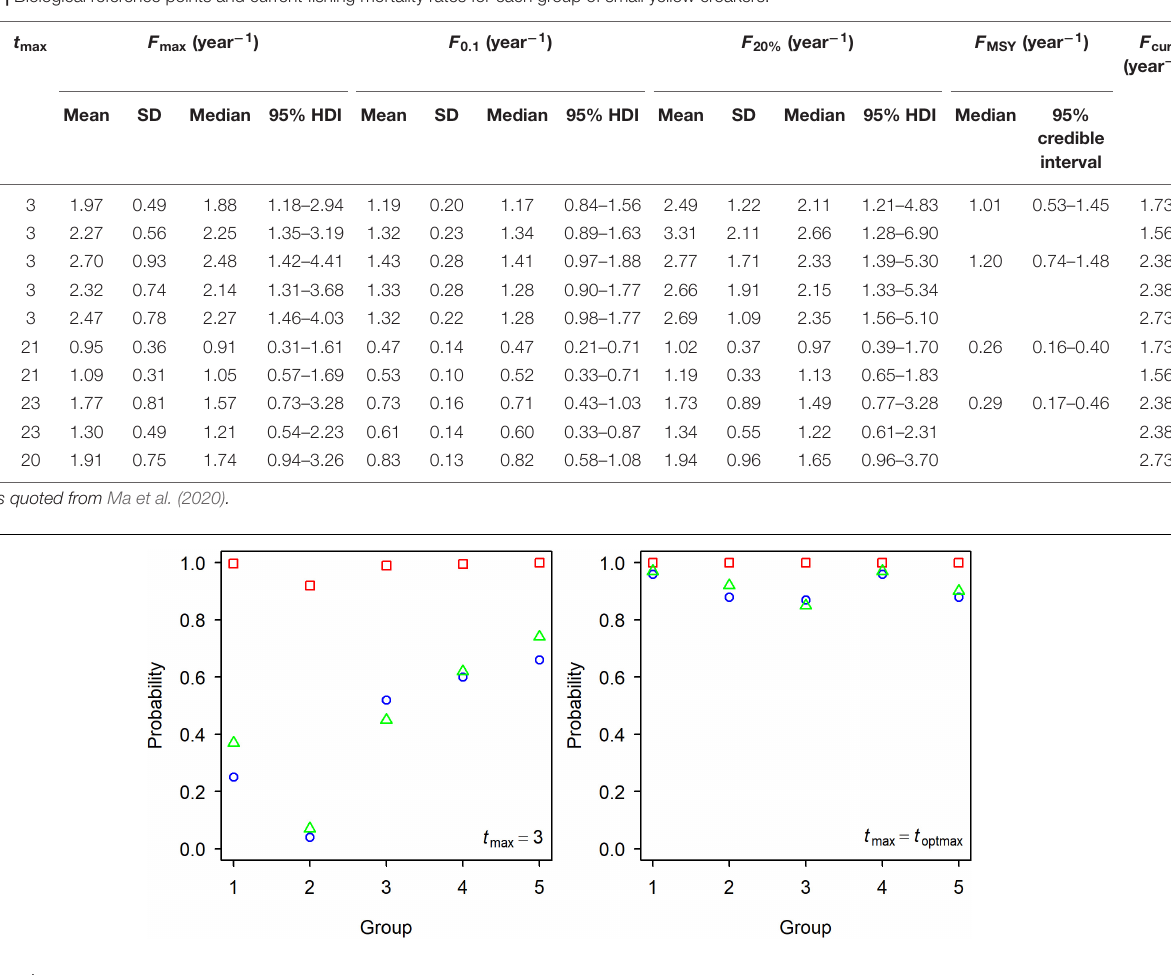
( Figure 9 ). SSBPR at F cur (SSBPR cur ) and SSBPR MSY had a similar distribution when L copt was used for each group. But uncertainty in the SSBPR increased when L c increased to the value of L copt as this increased the distribution of the SSBPR for each group. L copt could also lead to a higher yield when t max = 3 years ( Table 3 ). Median YPR would increase 14, 6, 11, 17, and 16% for Groups 1–5,